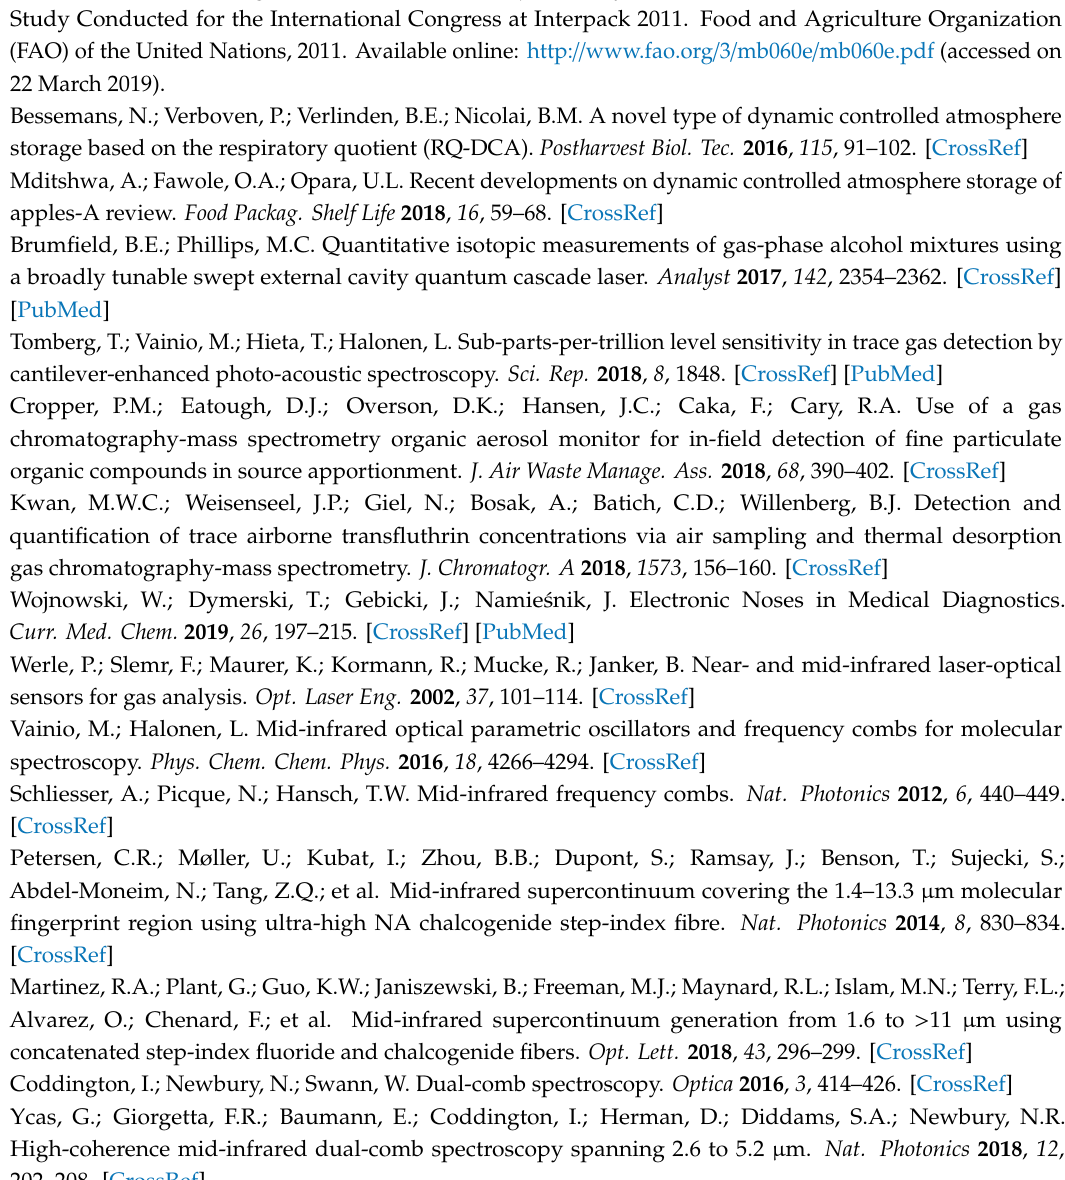
and the obtained global fit representing a concentration of 4.87 ppmv. Figure S7: Summary of the concentration values obtained from a series of measurements involving four di ff erent pear-storage